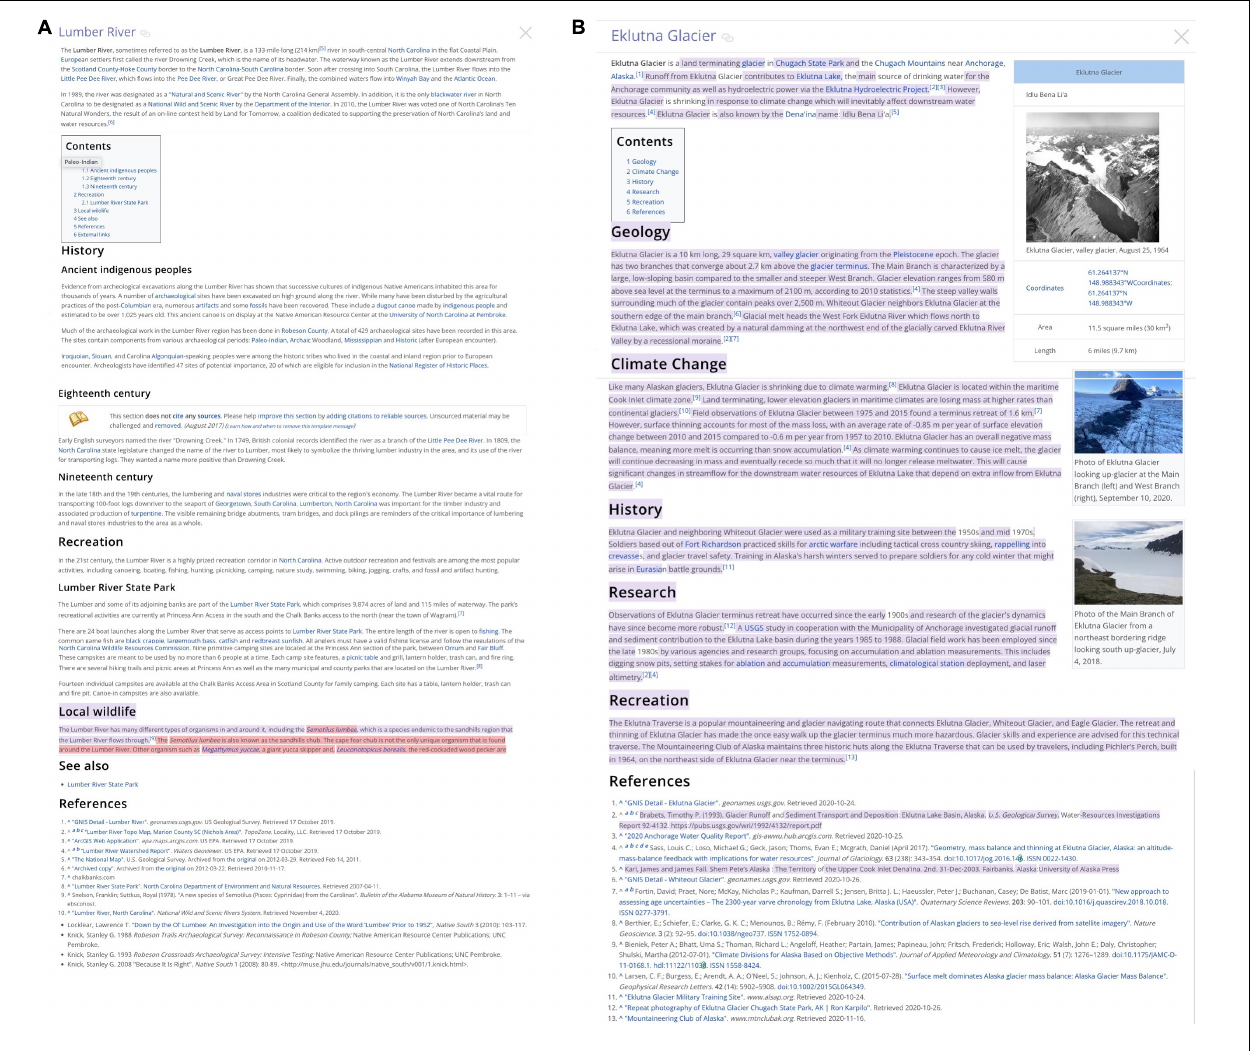
FIGURE 2 | Examples of student edits to Wikipedia in two of the courses taught by members of the Wikipedia Limnology & Oceanography faculty mentoring network that highlight the range of possible student edits and Wikipedia assignment complexity. Shaded text highlights student additions to each article, with different color shading indicating different student editors. The article on the Lumber River (A) was edited by two students, who jointly added 217 words and 2 references to the article, while the article on the Eklutna Glacier (B) was edited by one student, who added 2183 words and 19 references to the